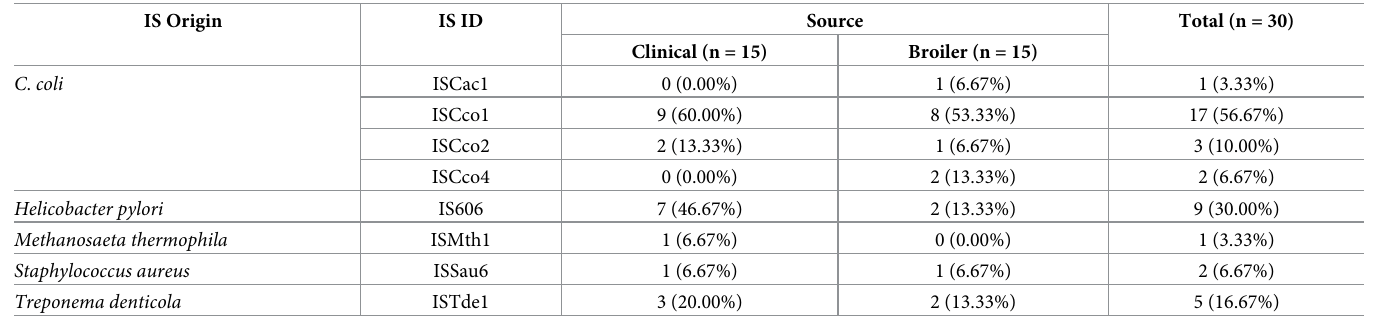
Table 3. Prevalence of insertion sequences (IS) detected in clinical and broiler genomes in this study. IS